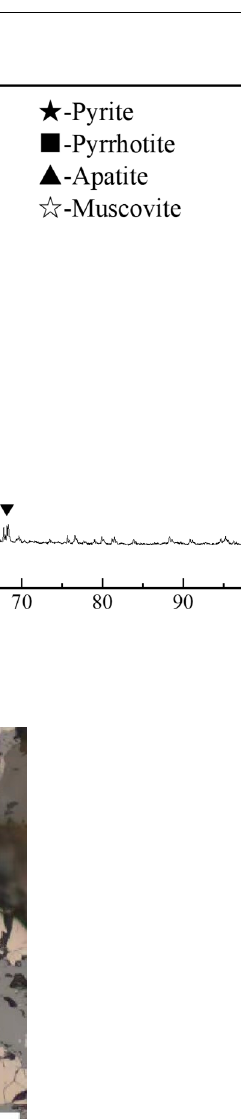
Figure 3. Symbiotic relationship of sulfide ore (reflective, ×100).